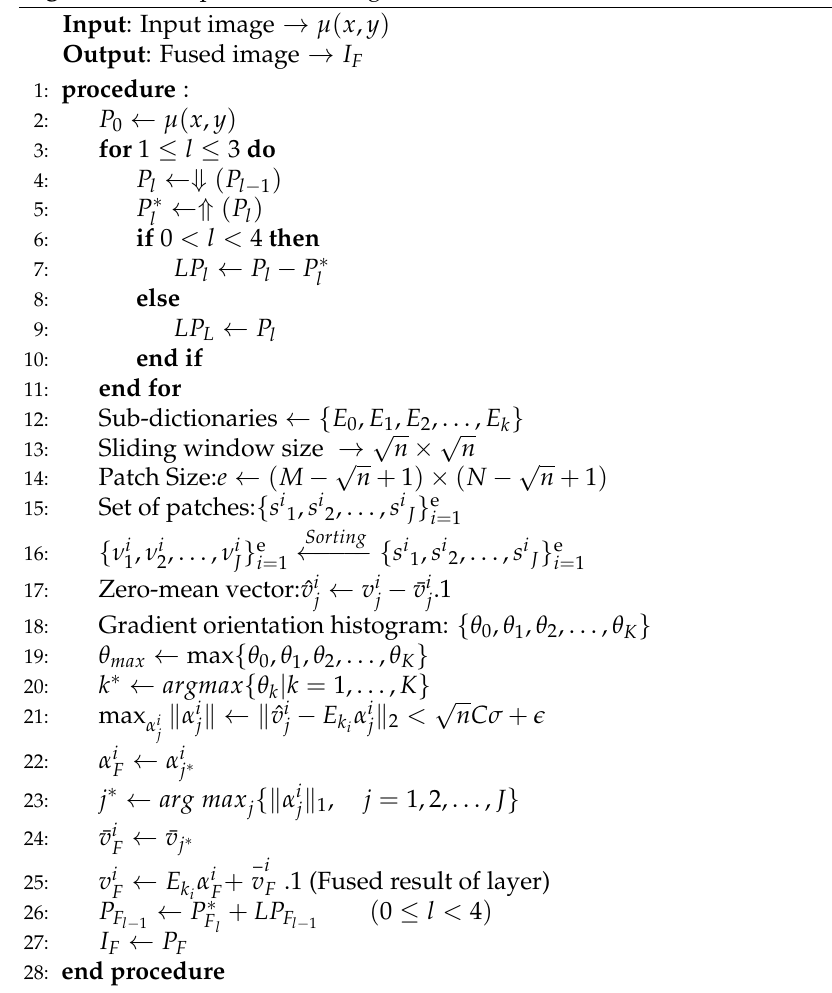
Algorithm 2 Proposed fusion